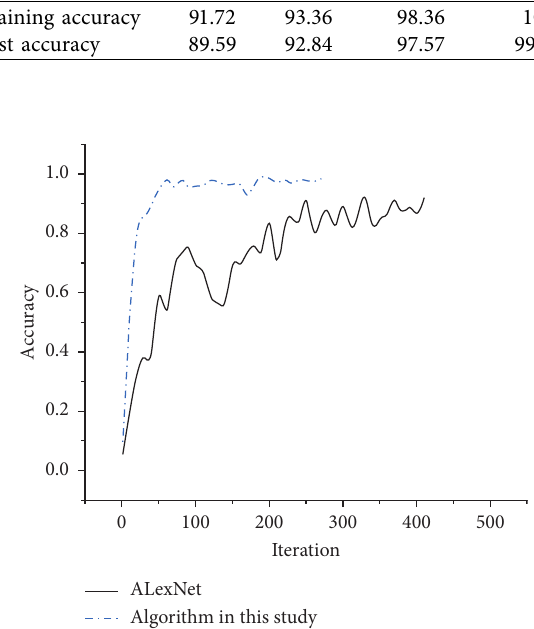
Figure 9: Accuracy during validation.